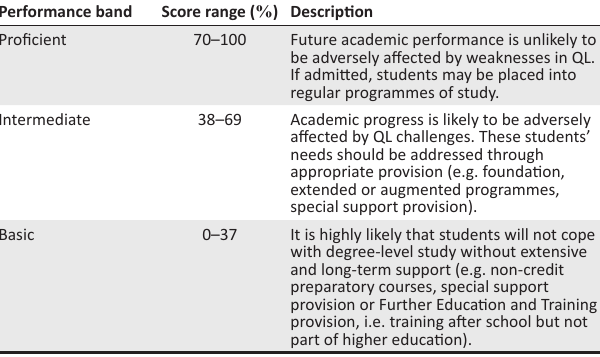
TABLE 3: National Benchmark Tests Project quantitative literacy test benchmarks for degree study, set in 2012. Performance band